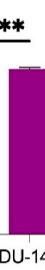
Figure 4. Basal level of total glutathione (reduced + oxidized) in different prostate cancer cell lines (PC-3 and DU-145). Bars represent means ± SEM (µM/mg of proteins), (****) p < 0.0001, Student’s t test, N = 3.